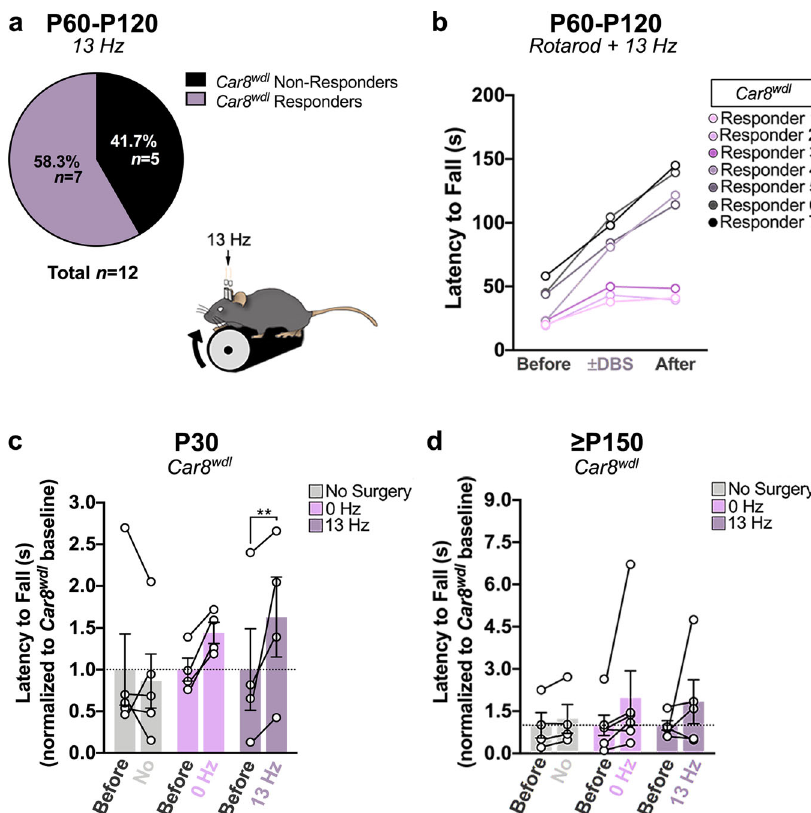
Fig. 5 Ataxia severity contributes to the DBS outcomes of Car8 wdl mice. a 58.3% of stimulated Car8 wdl mice ( n = 7/12) respond to 13 Hz DBS. b Improvements depend on the motor function of Car8 wdl mice prior to being stimulated at 13 Hz. Each line represents a Car8 wdl “ responder ” animal ( n = 7). c On average, P30 Car8 wdl mice improve with 13 Hz stimulation ( p = 0.0076). n = 13 biologically independent animals (No Surgery: n = 5; 0 Hz: n = 4; 13 Hz: n = 4) over 13 independent experiments. d On average, ≥ P150 Car8 wdl mice do not improve with 13 Hz stimulation ( p = 0.5557). n = 15 biologically independent animals (No Surgery: n = 4; 0 Hz: n = 6; 13 Hz: n = 5) over 15 independent experiments. ** p < 0.01; two-way ANOVA, repeated